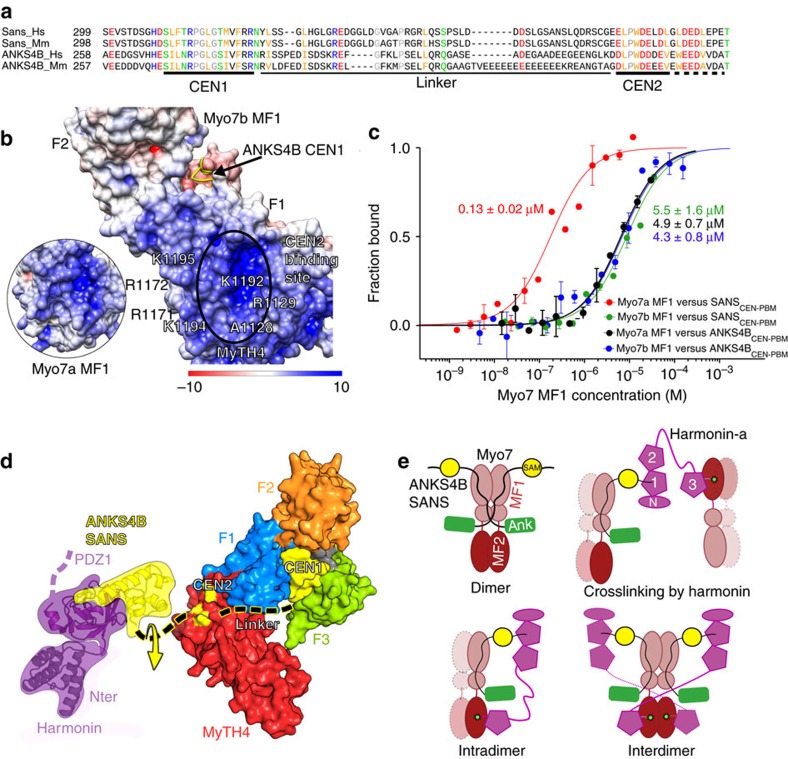
Myosin 7 MF1 binding to SANSCEN-PBM and ANKS4BCEN-PBM.(a) Alignment of SANS and ANKS4B CEN domain (Hs: human; Mm: mouse). Conserved residues are shown in red (negatively charged), blue (positively charged), yellow (hydrophobic), green (polar and not charged) and grey (proline and glycine). (b) Electrostatic surface potential of Myo7b MF1/ANKS4B (5F3Y) and Myo7a MF1/SANS (3PVL) (inset). The residues found in the positively charged pocket in the MyTH4 domains that participate in SANS or ANKS4B CEN2 binding are indicated (note that the CEN2 region is highly negatively charged, (a)). The surface potential was calculated using the APBS server with default parameters. (c) MST curves comparing the Myo7 MF1.SH3 binding to either SANSCEN-PBM or ANKS4BCEN-PBM. Averaged Kds from two technical replicates (mean±s.d.) are shown. (d) Model of the tripartite Myo7 MF1-SANS/ANKS4B-Harmonin complex. The Myo7 MF1 is shown in a surface representation, with the binding site of CEN2 highlighted in yellow. CEN1 and SAM of ANKS4B or SANS are also shown in yellow. The linkers are shown as black dashed line. The short variable linker between CEN2 and SAM domain is likely flexible, allowing for movement of the SAM domain relative to the Myo7 tail (yellow arrow). (e). Cartoon models showing the different tripartite complexes that could be assembled. Full length SANS can dimerize via a region between the ANKyrin domain and CEN1 (ref. 35) and, thus, potentially facilitates Myo7 dimerization (dimer). While interacting with MF1 (brown) via SANS/ANKS4B (yellow and green), the long CC1 region of harmonin may allow PDZ3c to reach a MF2 of another Myo7 molecule (crosslinking), the same Myo7 molecule (intradimer), or the other MF2 in the same myosin dimer (interdimer).